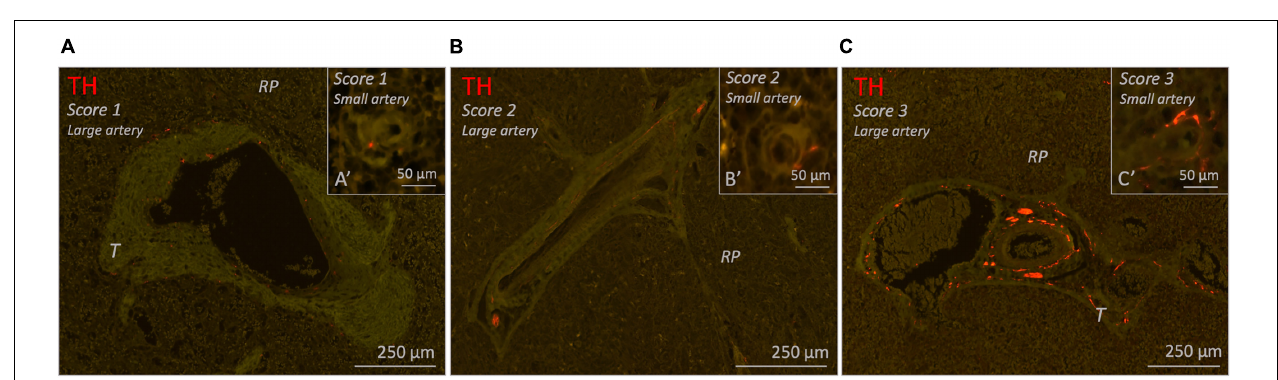
FIGURE 5 | Fluorescence microscopic images of various trabecula related sympathetic nerve densities (TH staining) in different neonatal individuals. (A) Spleen without trabecular sympathetic nerves (score 0). (B) Trabecula with a low density (score 1) of sympathetic nerves. A few small nerves are present within the connective tissue of the trabecular and a few nerves can be observed on its outer margin where they are in proximity to the RP. (C) Trabecula with a low density (score 1) of sympathetic nerves. Perivascular nerves can be observed in the adventitia of a small blood vessel (trabecular artery) and in the connective tissue of the trabecula from where it diverges to its outer margins where a few nerves are bordering the RP. (D) Trabecula extending from the capsule with a moderate density (score 2) of sympathetic nerves. Most nerves are in proximity to the RP and on its cranial site a nerve extents into the RP. Sympathetic nerves in parts of trabeculae directly extending from the capsule were very sparse. (E) Comparable to (C) but this figure contains a larger trabecular artery and shows a moderate density (score 2) of sympathetic nerves. (F) Trabecula with a high density (score 3) of sympathetic nerves which diverge to the trabecula’s outer border to be in proximity to the RP.